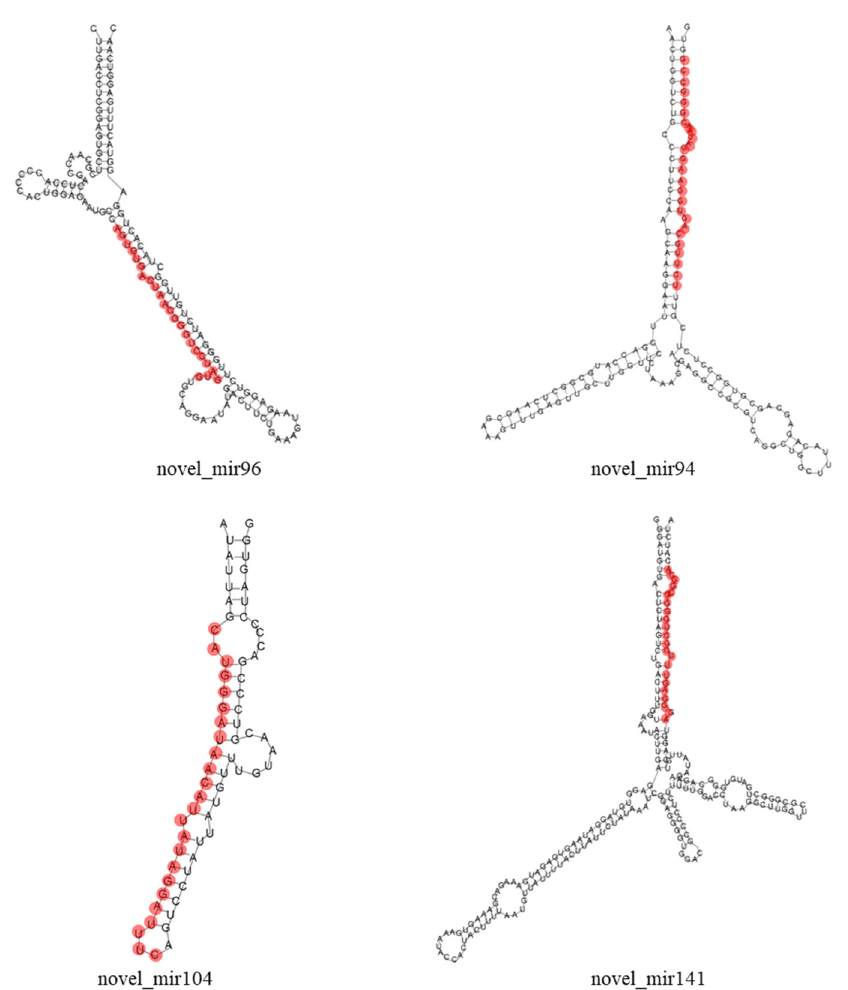
Figure 3. Precursor structure prediction of four novel miRNAs differently expressed in ZL and FS in response to Al stress. Red bars indicate the sequence of mature miRNAs.